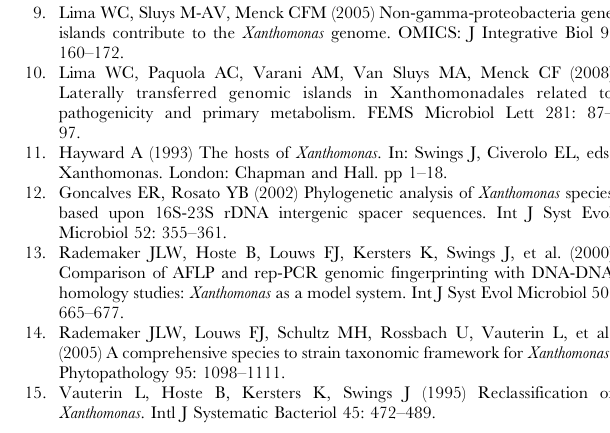
Table S1 Xanthomonas genome sequences examined in this study.